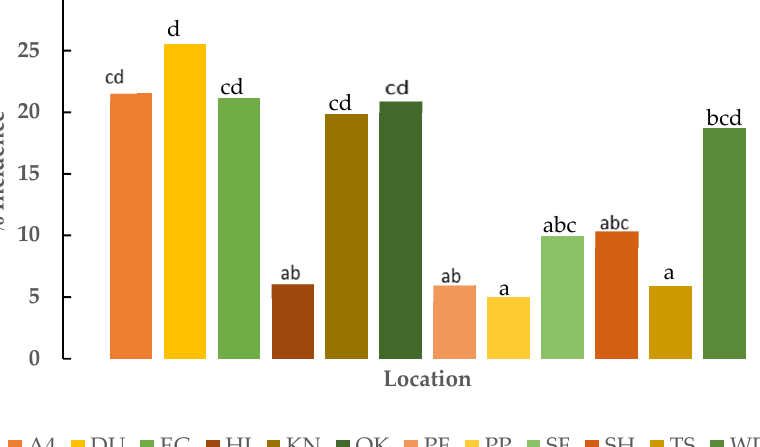
Figure 4. Percent incidence of sugarcane yellow leaf virus in varieties in the primary and secondary increase trials in different years. Percent incidence values with different lower case letters are sig- nificantly different ( p < 0.05).